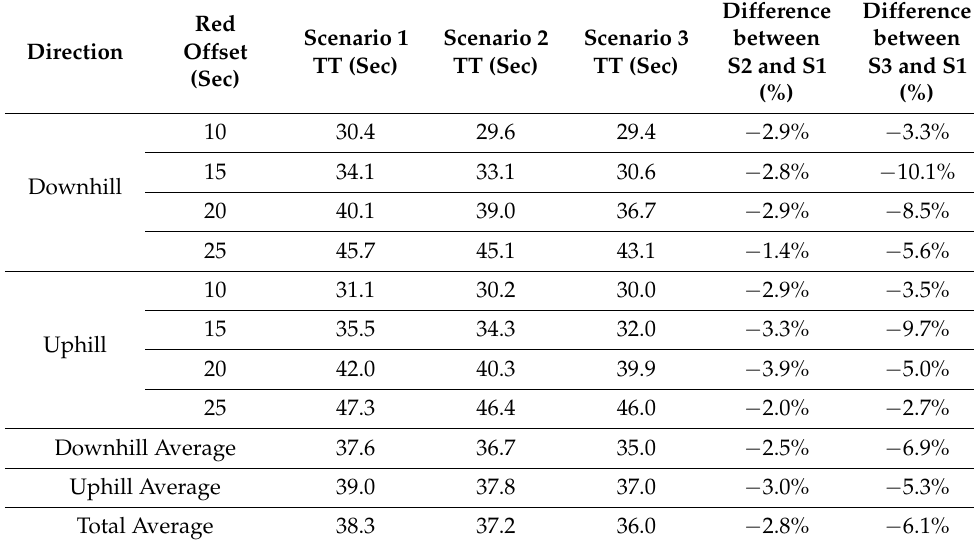
Table 3. Average trip travel times.